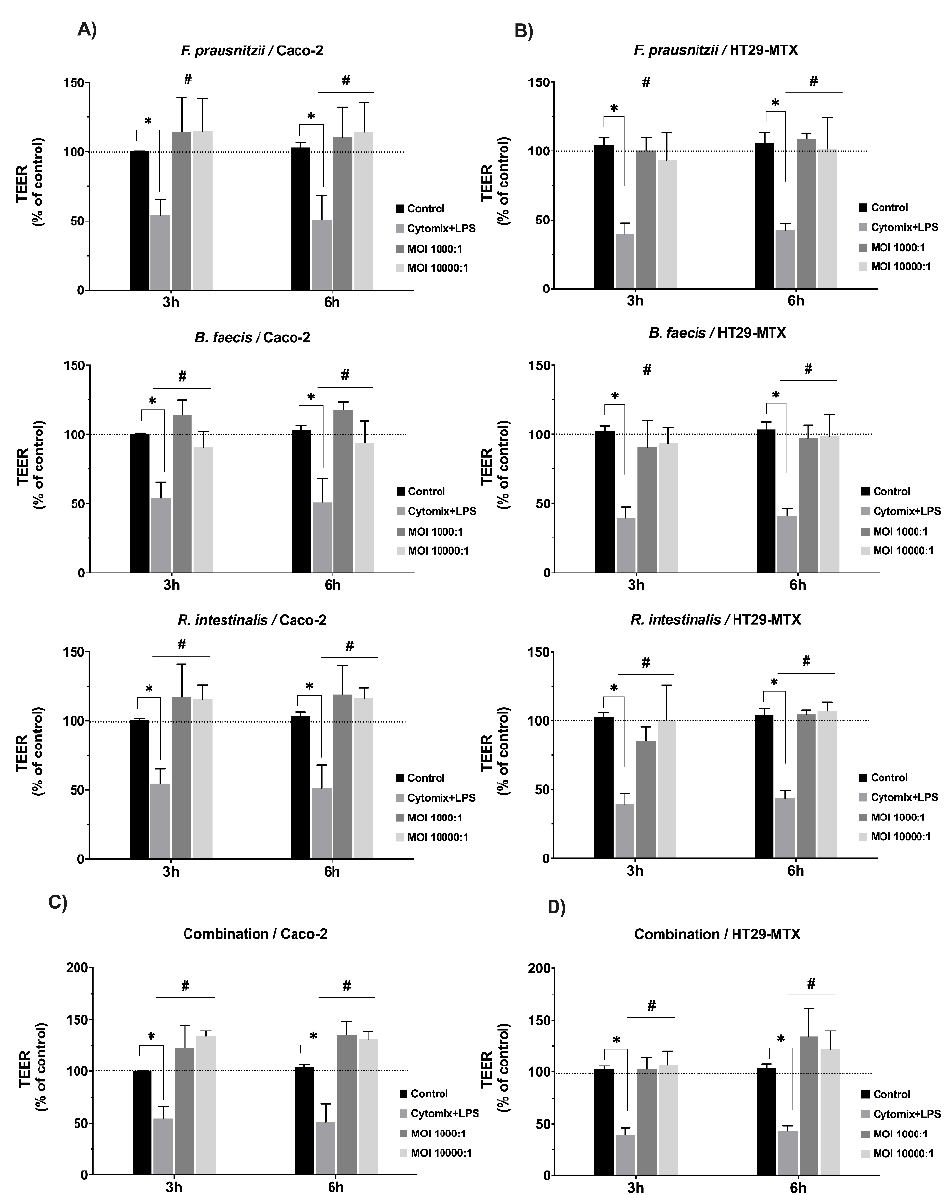
Figure 2. Effect of F. prausnitzii , B. faecis and R. intestinalis individually ( A , B ) and in combination ( C , D ) on the transepithelial electrical resistance (TEER) in Caco-2 and HT29-MTX cells monolayers. Both cell lines were treated basolaterally with cytomix + lipopolysaccharide (LPS) for 48 and 10 h, respectively. Cells without any treatment were used as a control. Data are presented as the means ± SD ( n ≥ 5). * p ≤ 0.05) cytomix + LPS compared to the control and # p ≤ 0.05 treated groups compared to cytomix + LPS, as determined by the Mann–Whitney U